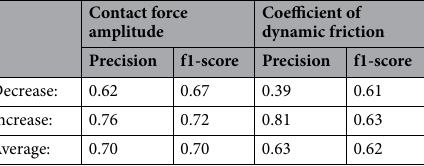
Table 2. Classification performance with a binary logistic regression for the changes in the contact force amplitude and the coefficient of dynamic friction.